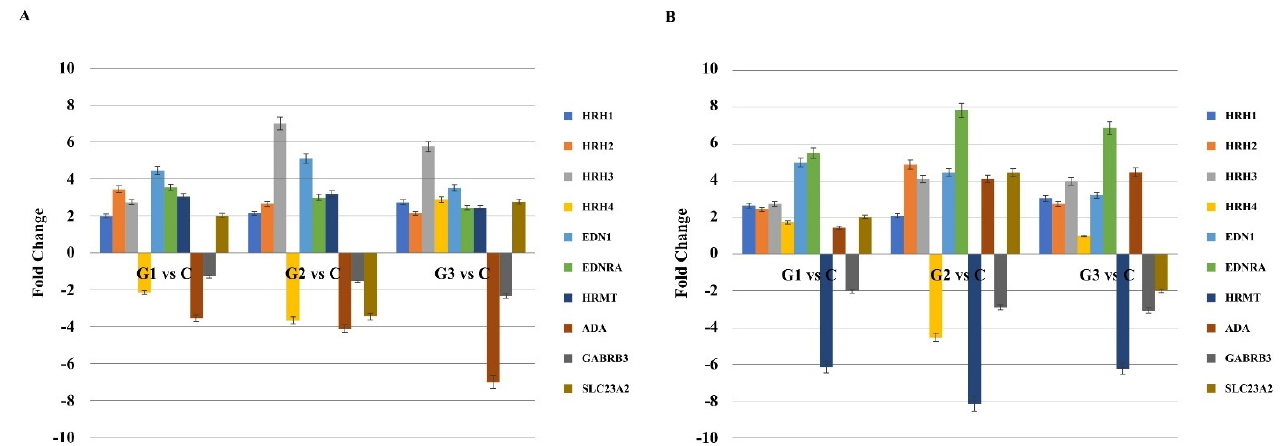
Figure 1. Changes in the expression pattern of genes related to the histaminergic system in endometrial cancer samples ( A ) and whole blood ( B ) in comparison to the control obtained via RTqPCR ( p < 0.05). (+)—overexpression in comparison to the control; (-)—downregulated in comparison to the control; G—grading; C—control; HNMT—histamine N-methyltransferase; HRH1-3—histamine receptor 1-3; GABRB3—gamma-aminobutyric acid (GABA) A receptor, alpha 3; EDN1—endothelin 1; EDNRA—endothelin receptor type A; SLC223A2—solute carrier family 22 member 3 .